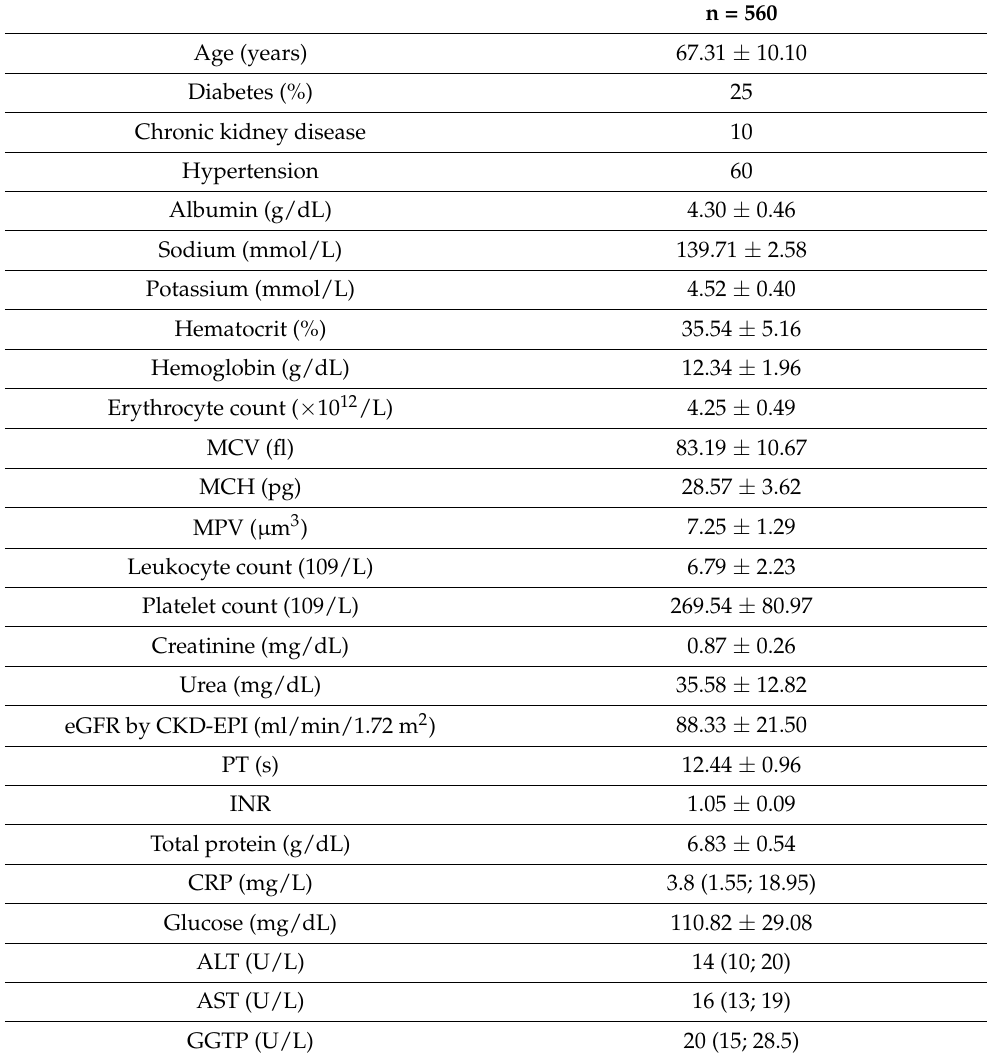
Table 1. Clinical and biochemical data of the studied patients with colorectal cancer undergo- ing